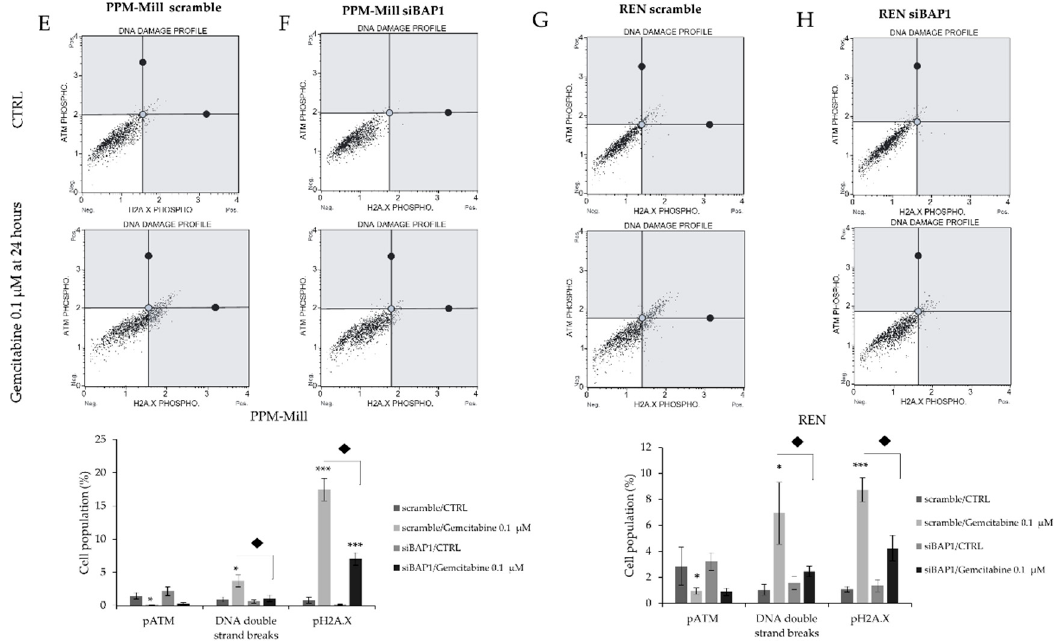
Figure 4. DNA damage assay in PPM-Mill, REN, Phi, and ROB un-transfected cells ( A – D ) or transfected with either scramble or siRNA targeting BAP1 PPM-Mill and REN cells ( E – H ). All cells were either treated with 0.1 µ M gemcitabine or DMSO that was used as vehicle (CTRL). The analysis was performed using Muse Analyser. Statistical analysis is described in Materials and Methods section. * p ≤ 0.05, ** p ≤ 0.01, *** p ≤